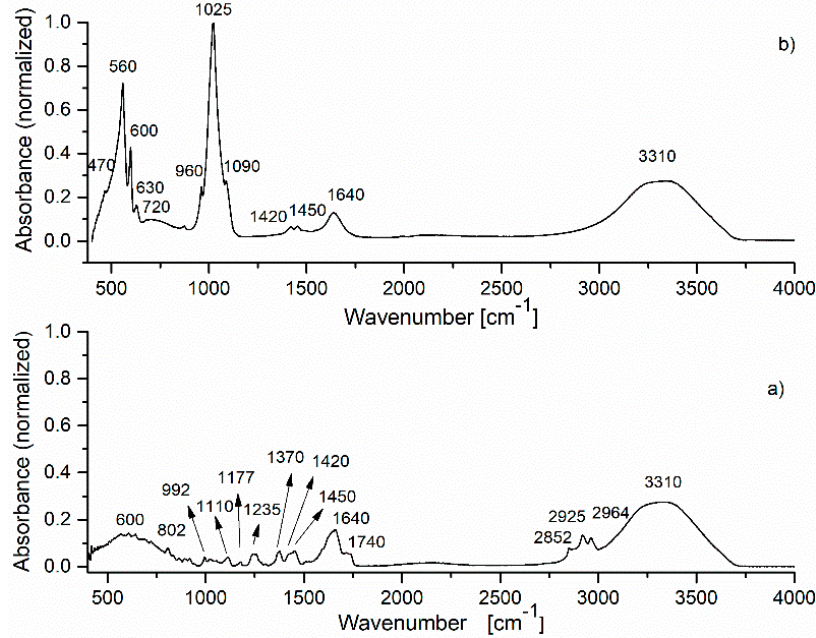
Figure 3. FTIR spectrum of: ( a ) basil essential oil; ( b ) HAp-B sample.